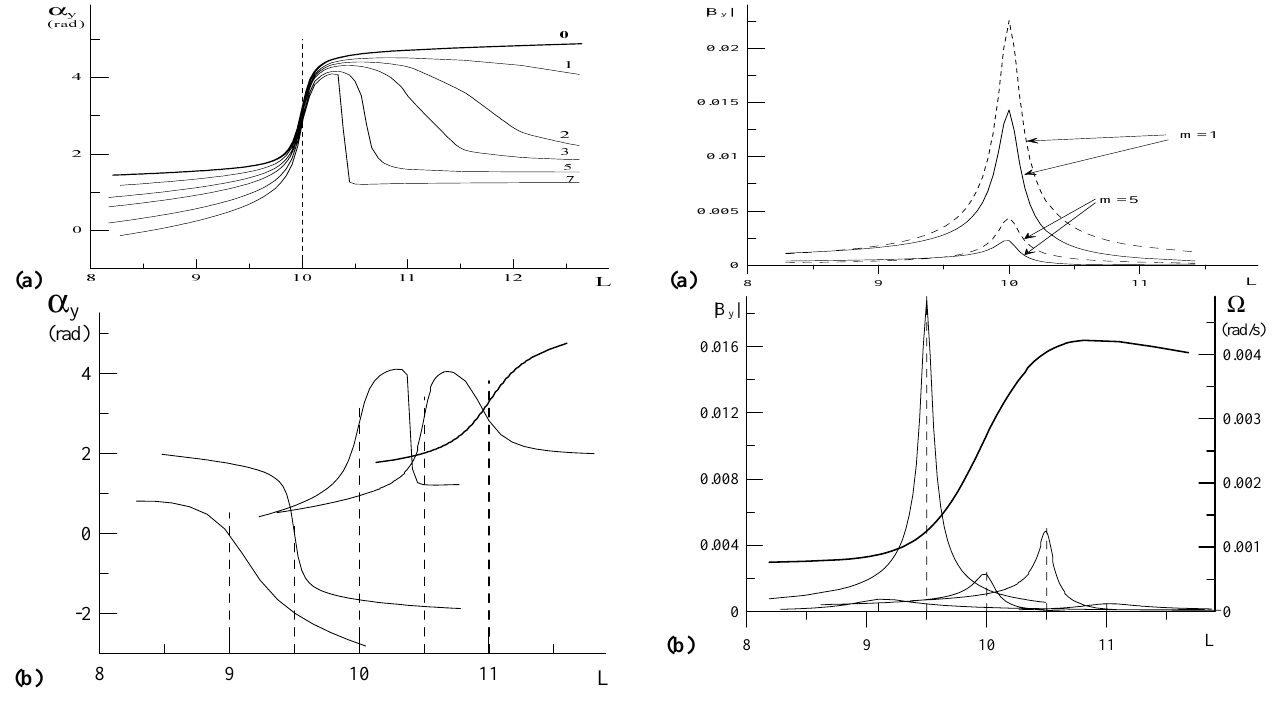
Fig. 5. The distribution of the resonant Alfv´en oscillation phase α y across magnetic shells. Panel (a) presents the distribution of α y (x 1 ) in the model with moving plasma on the magnetic shell L = 10 for the harmonics N = 1 , m = 1 , 2 , 3 , 5 , 7, as well as in the case of stationary plasma ( (cid:127) = 0) (that is similar to the choice of m = 0). Panel (b) displays the distribution of α y (x 1 ) for the har- monic N = 1 , m = 7 on different resonant shells within the transition layer.